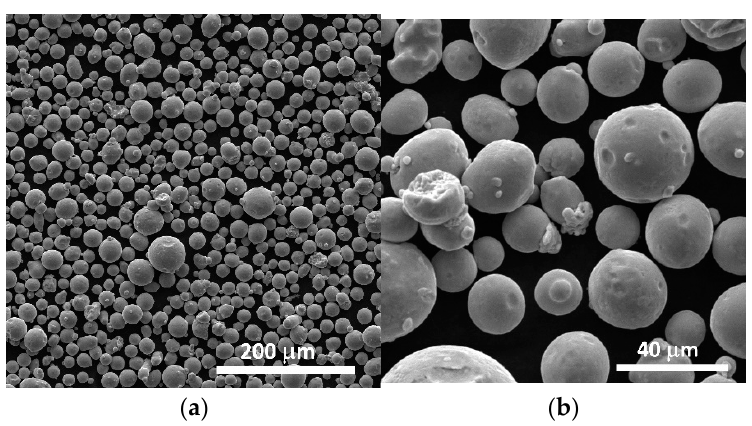
Figure 2. Morphology of the CL20ES powder used for SLM with ( a ) 1.49k× SEM magnification and ( b ) 1.65k× SEM magnification.